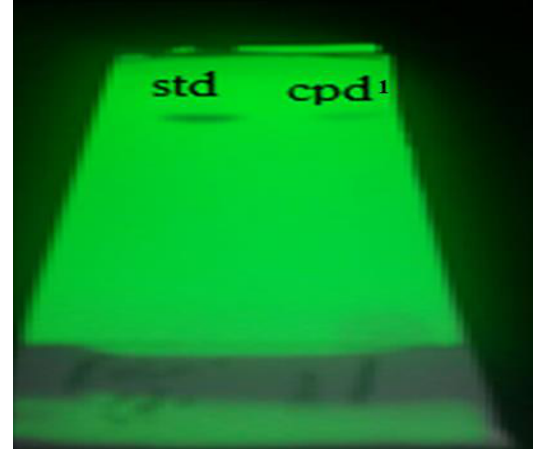
Figure 7. TLC chromatography for isolated compound number (1) from ethyl acetate fraction and Rosmarinic acid standard using silica gel Gf254 as adsorbant and mobile phase S3.